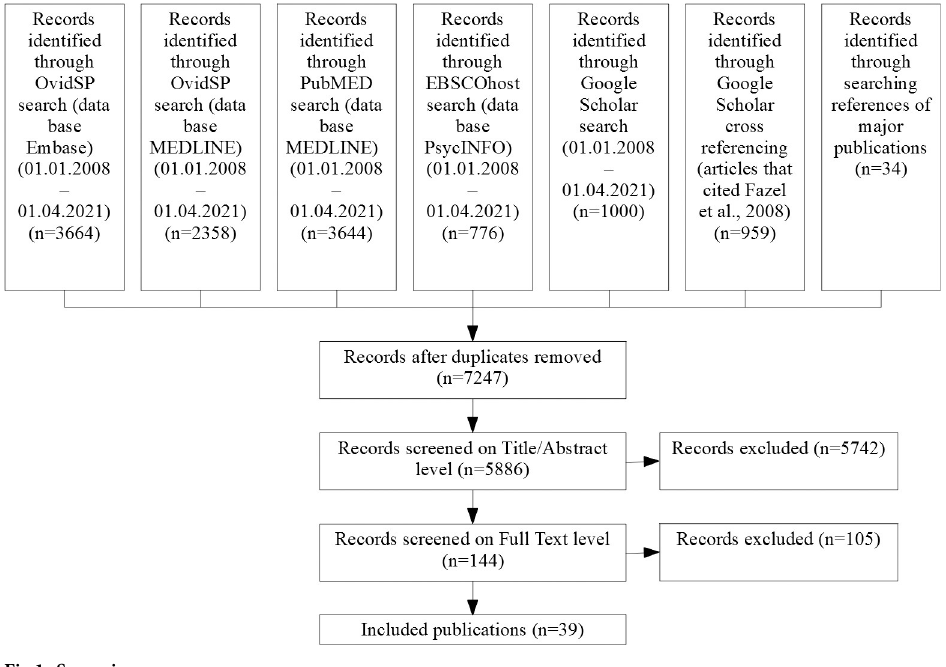
Fig 1. Screening